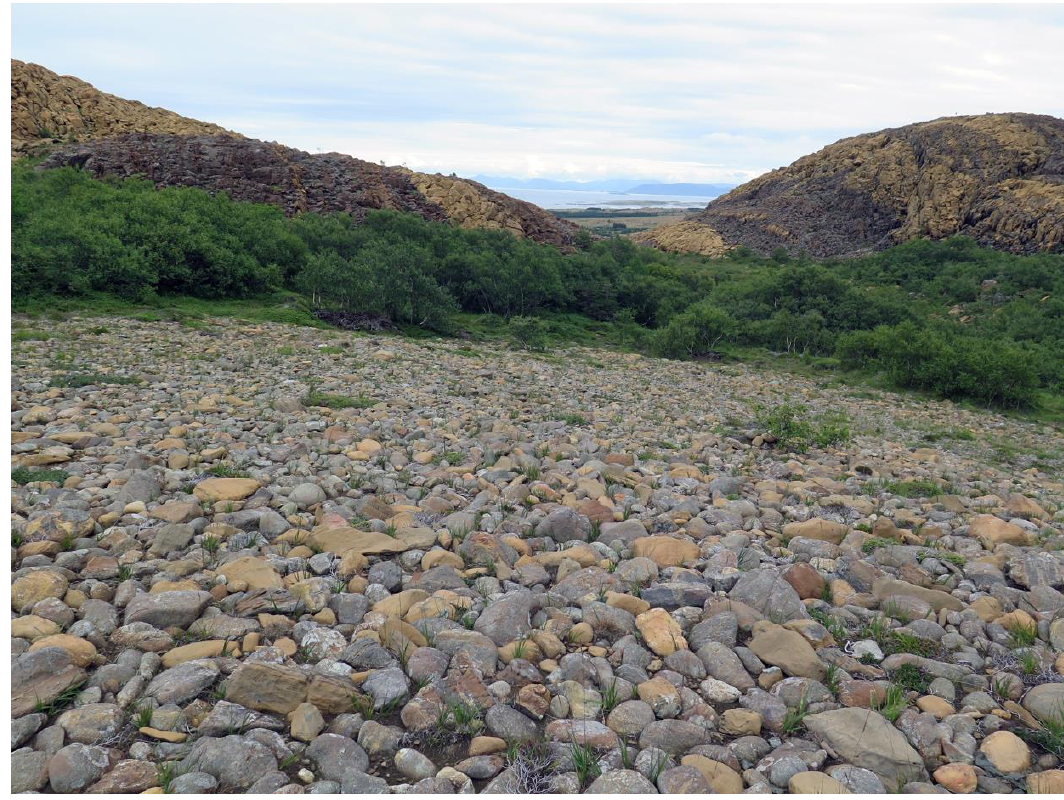
Figure 6. View from the mid-valley beach deposit over the slope descending to the NE.